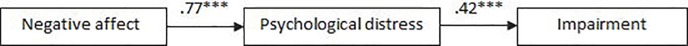
Empirically supported model of disruption to work/study activities during the week before completing a shift on the crisis line.